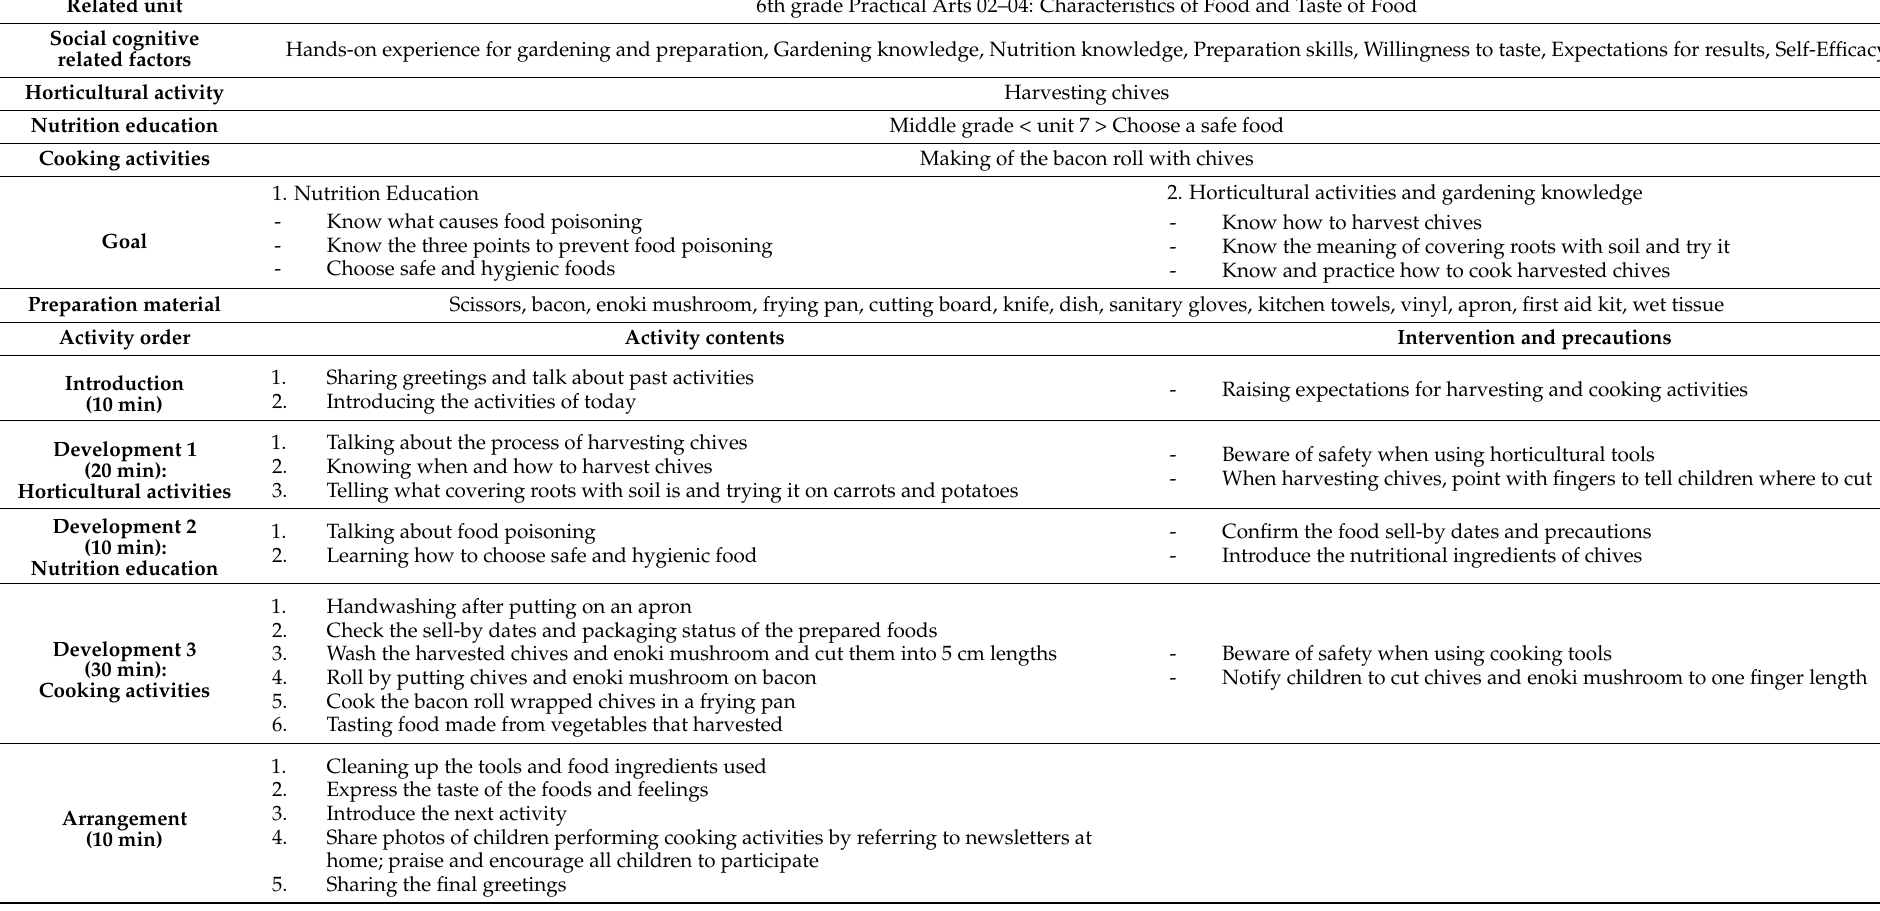
Table 2. Example of a session of the horticultural activity program (6th session). From Garden to